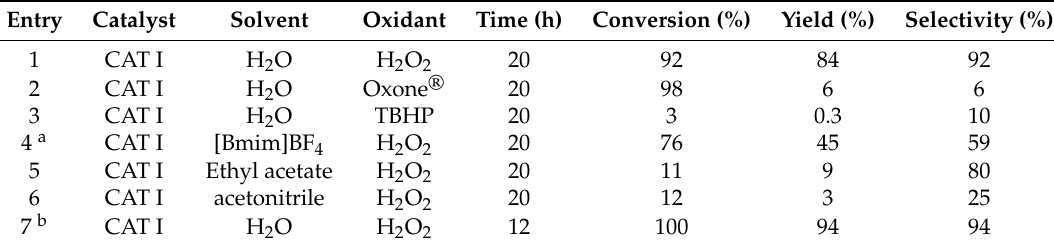
Table 3. Epoxidation of cyclooctene with different catalysts, solvents and oxidants.